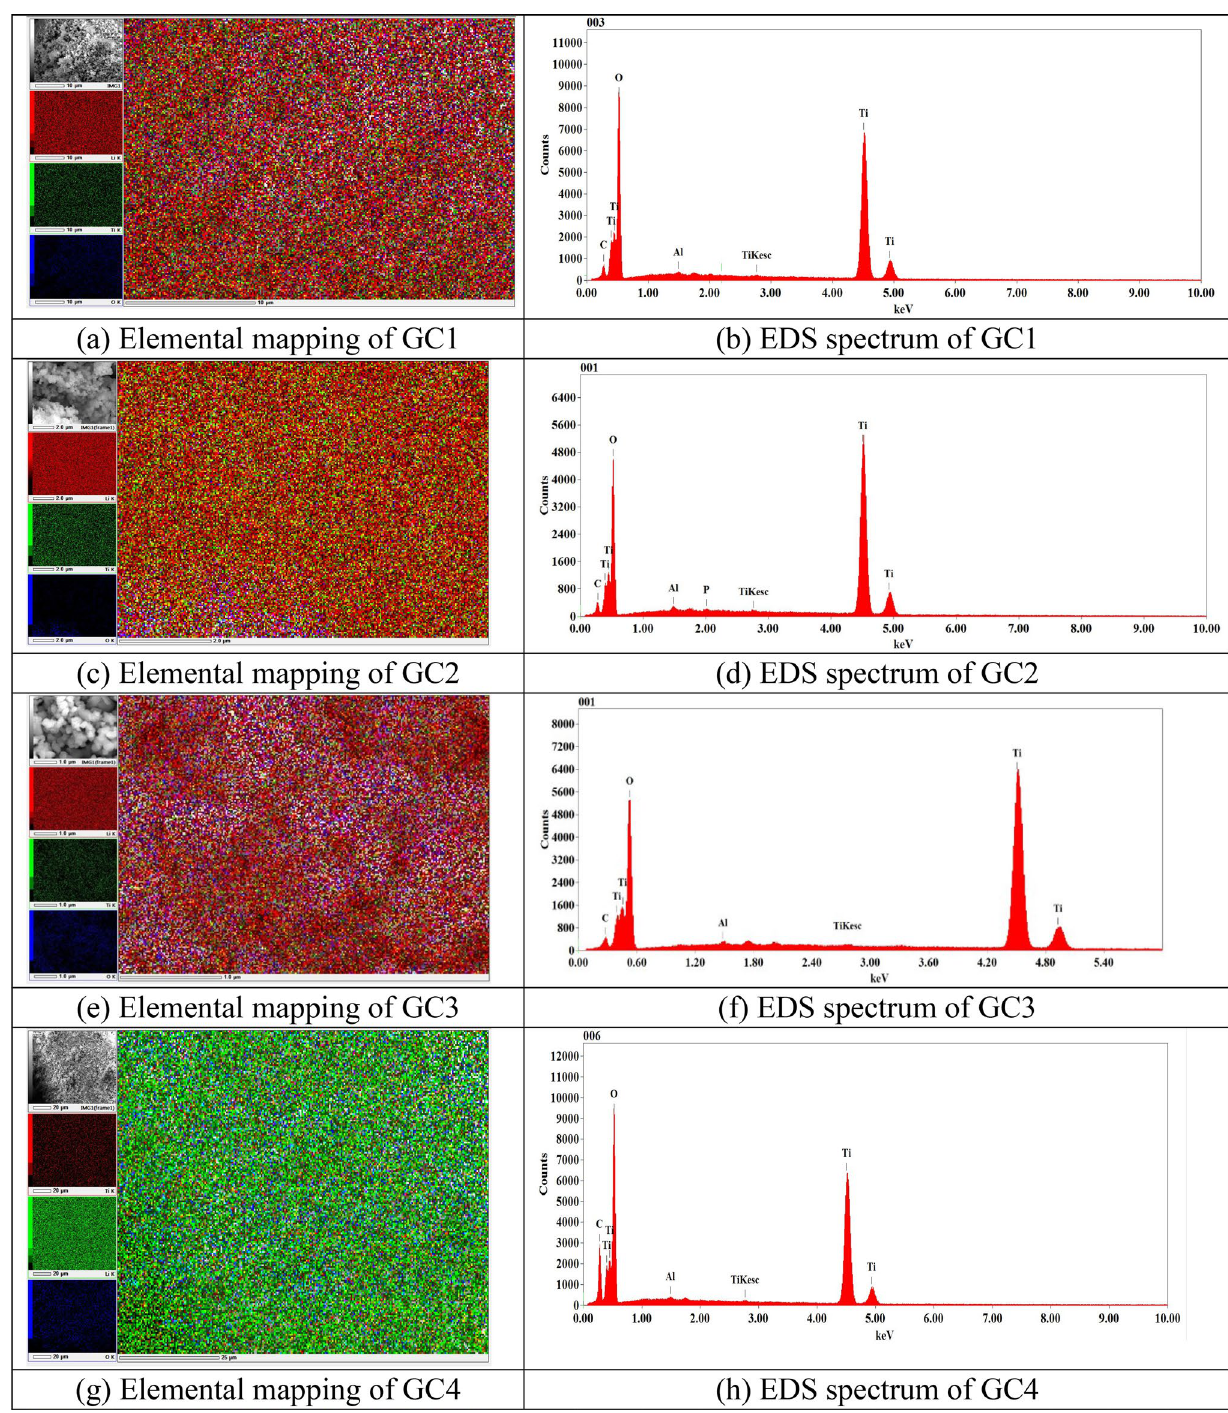
Fig. 5 Elemental mapping and corresponding EDS spectrum of LTO